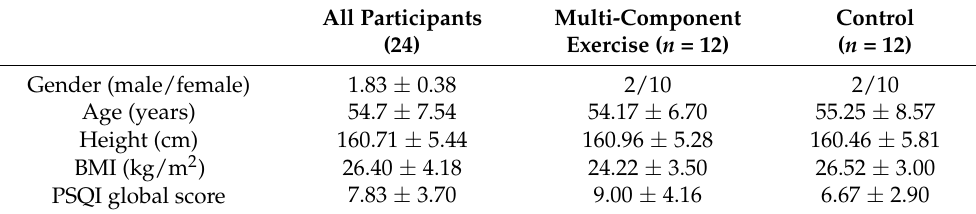
Table 1. Sample characteristics (M ±